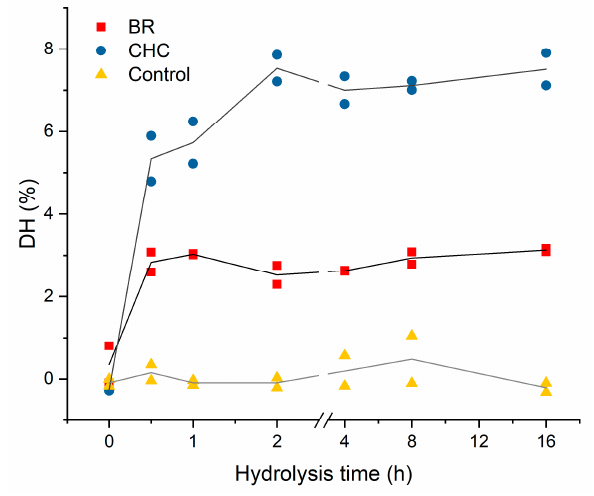
Figure 1. Degree of hydrolysis (DH). DH is expressed in percentage as a function of hydrolysis time expressed in hours. BR: bromelain; CHC: collagenase; Control: without enzyme. Through the analysis of the electrophoresis (Figure 2), the bands at the initial time (with